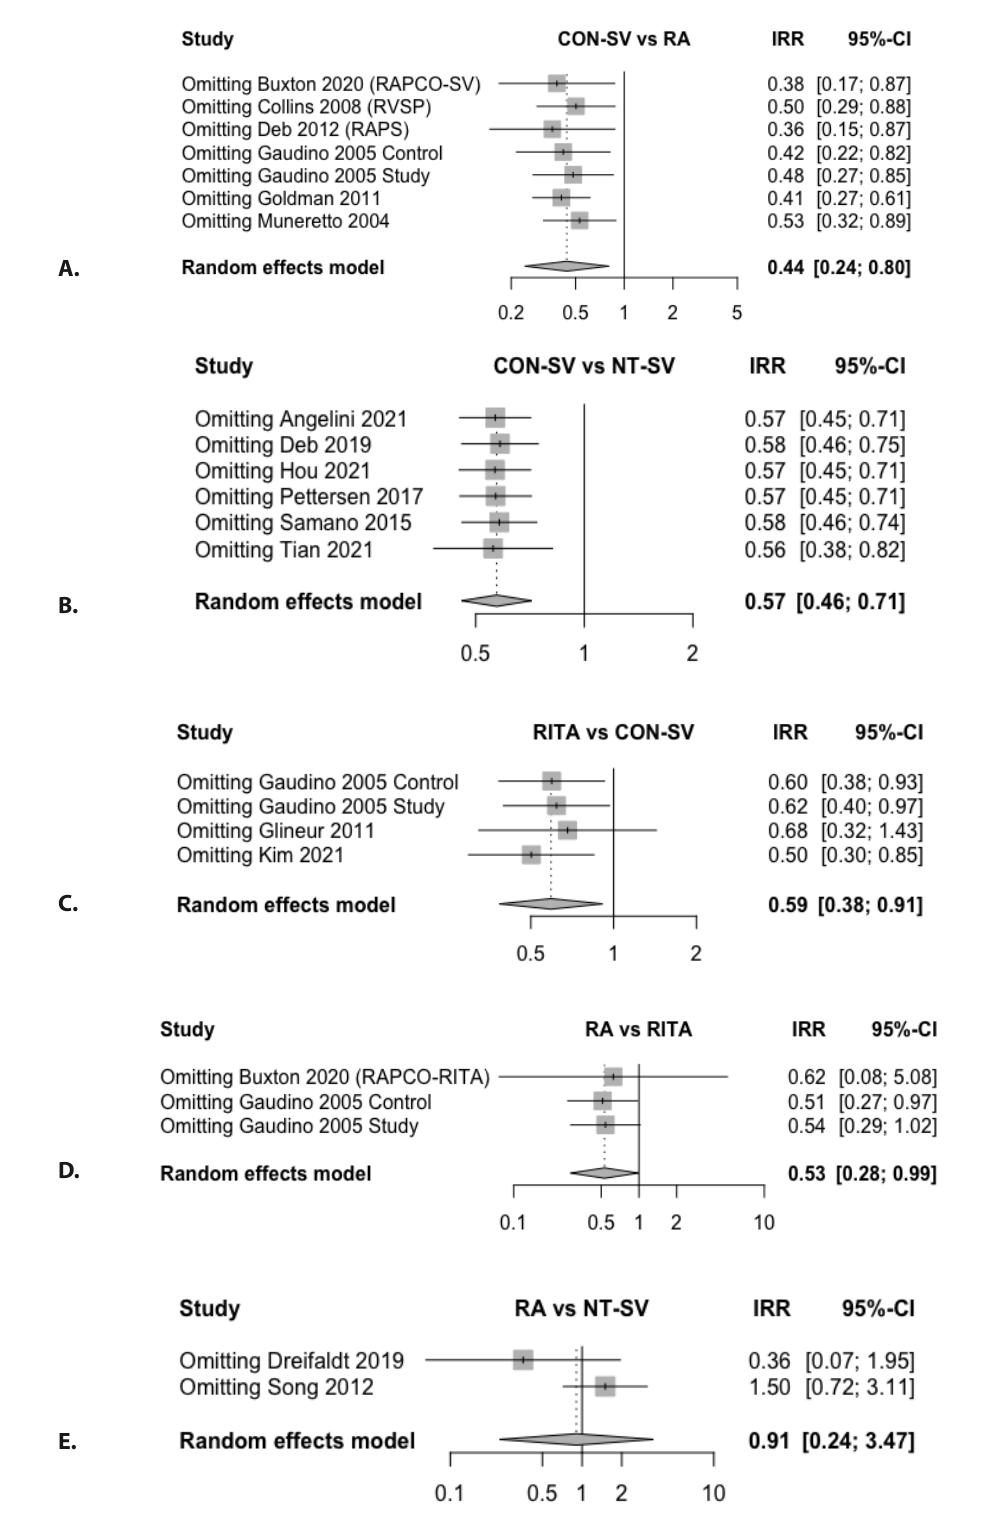
Fig. S6 - Leave-one-out analysis for graft occlusion in A) radial artery (RA) vs. conventionally harvested saphenous vein (CON-SV); B) no-touch saphenous vein (NT-SV) vs. CON-SV; C) right internal thoracic artery (RITA) vs. CON-SV; D) RA vs RITA; E) RA vs. NT-SV. CI=confidence interval; IRR=incidence rate ratio; RAPCO=Radial Artery Patency and Clinical Outcomes; RAPS=Radial Artery Patency Study; RSVP=Radial Artery Versus Saphenous Vein Patency; SV=saphenous